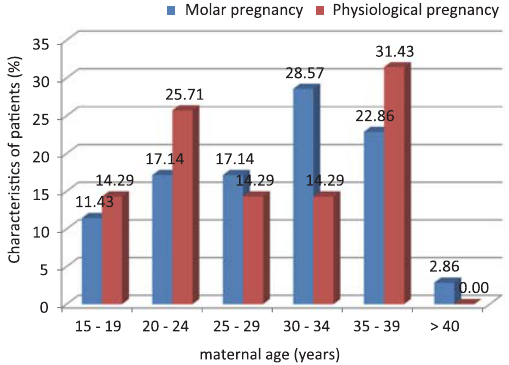
FIGURE 1. Characteristics of pregnant women according to their age Th e average age was 28.63 years in the control group with the average deviation of 8.17 years. Th e most frequent age in the control group was 22 years while